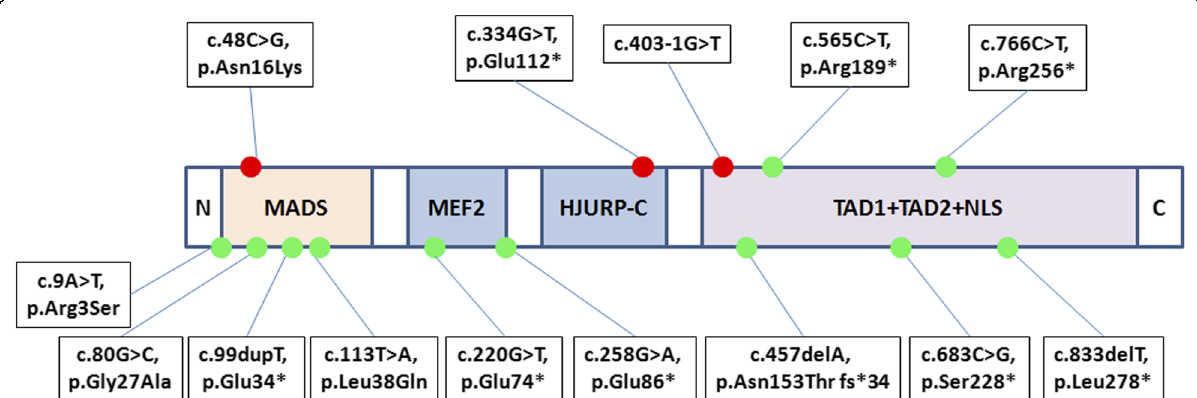
Fig. 1 The structure of the MEF2C protein and the location of MEF2C mutations. Red dots: Novel mutations found in this study. Green dots: Reported mutations. The upper line: Five MEF2C mutations identified in this study. The lower line: Nine MEF2C mutations that has been described previously. N, N-terminus; MADS, MCM1, agamous, deficiens, serum response factor; MEF2, myocyte enhancer factor 2; TAD, transcriptional activation domain; NLS, nuclear location signal; C,